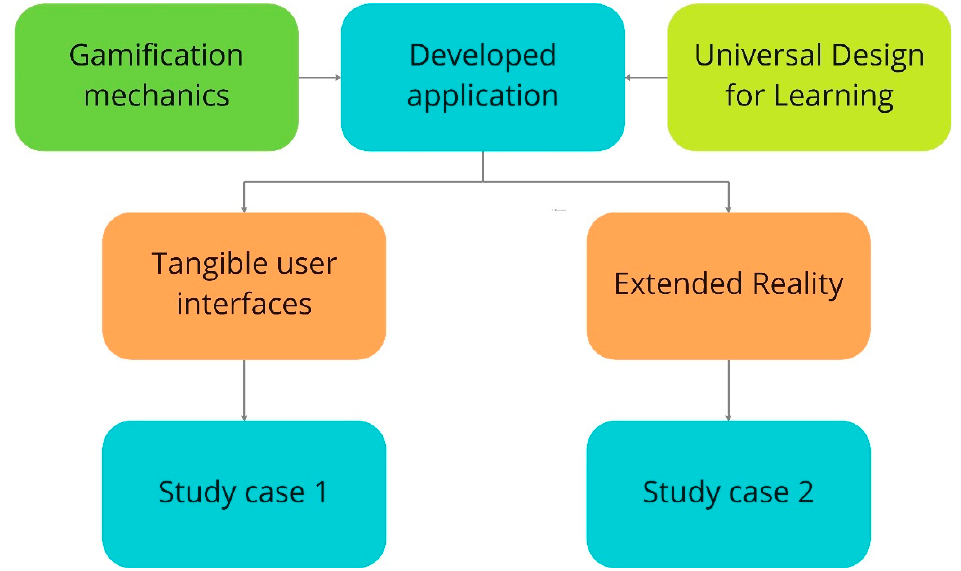
Figure 3. Interaction between gamification mechanics, universal design for learning, tangible user interfaces and extended reality in study cases presented in this paper.